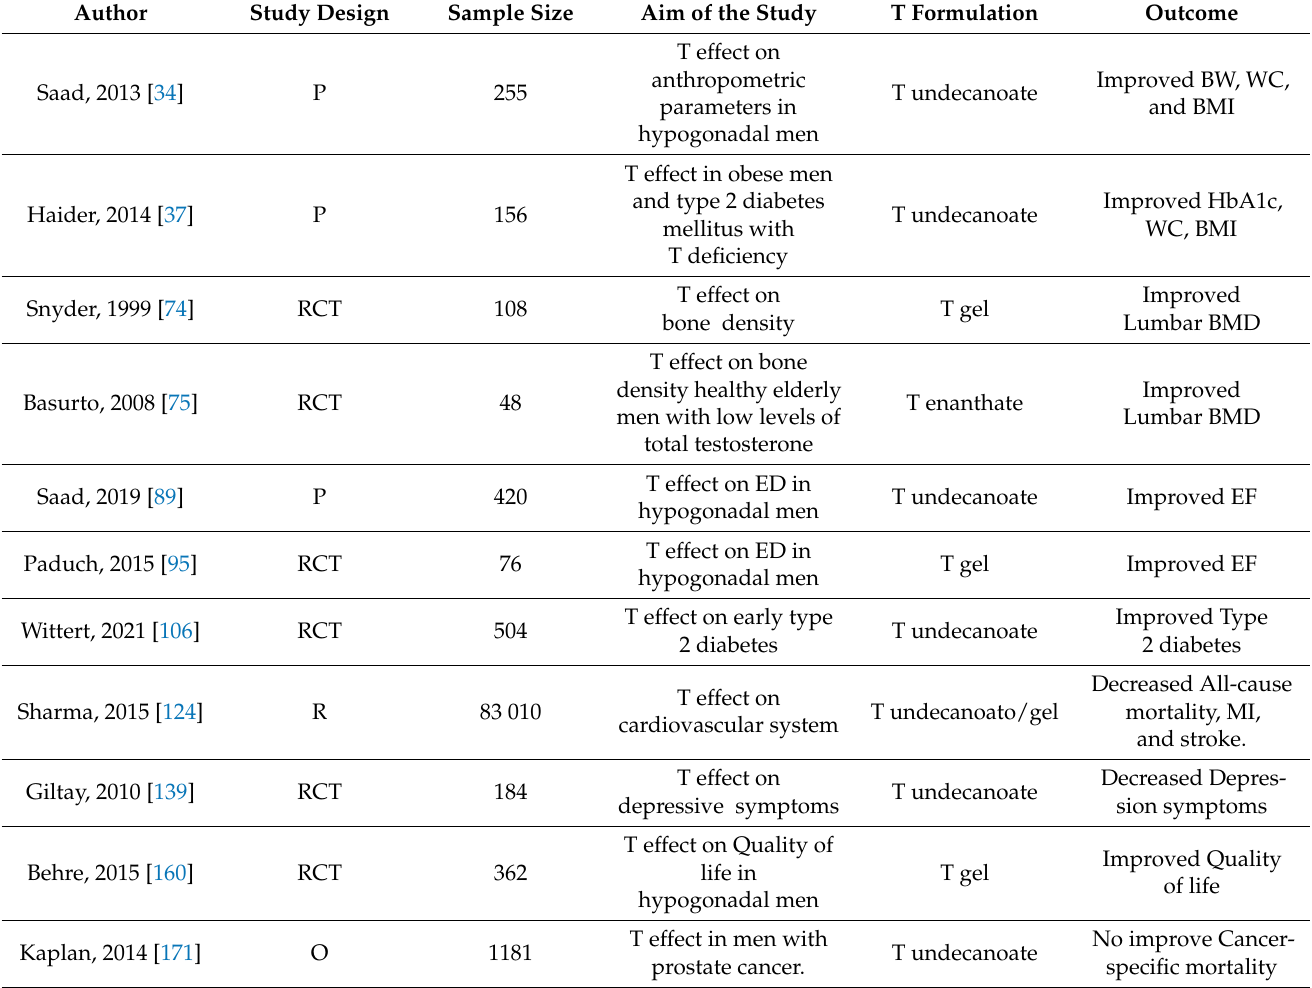
Table 1. Effects of Testosterone Replacement